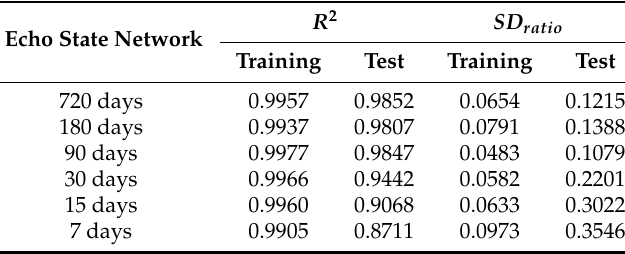
Table 9. Performance index for training and test of new networks.